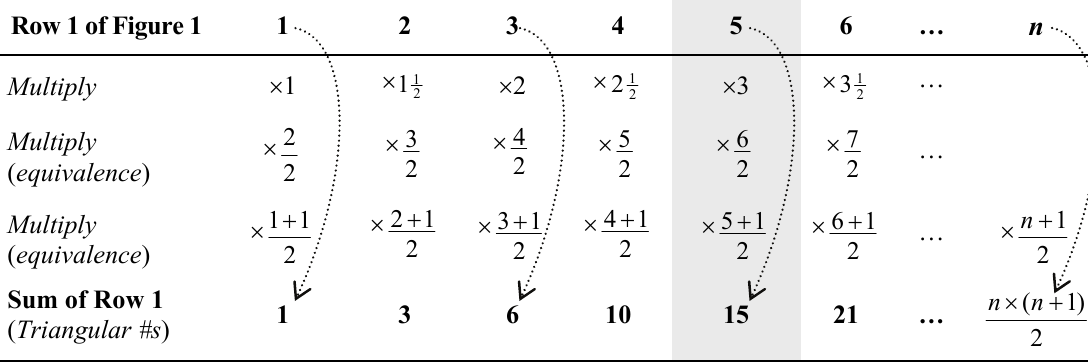
Figure 6 : Generating triangular numbers by summing the numbers in Row 1 in Figure 1